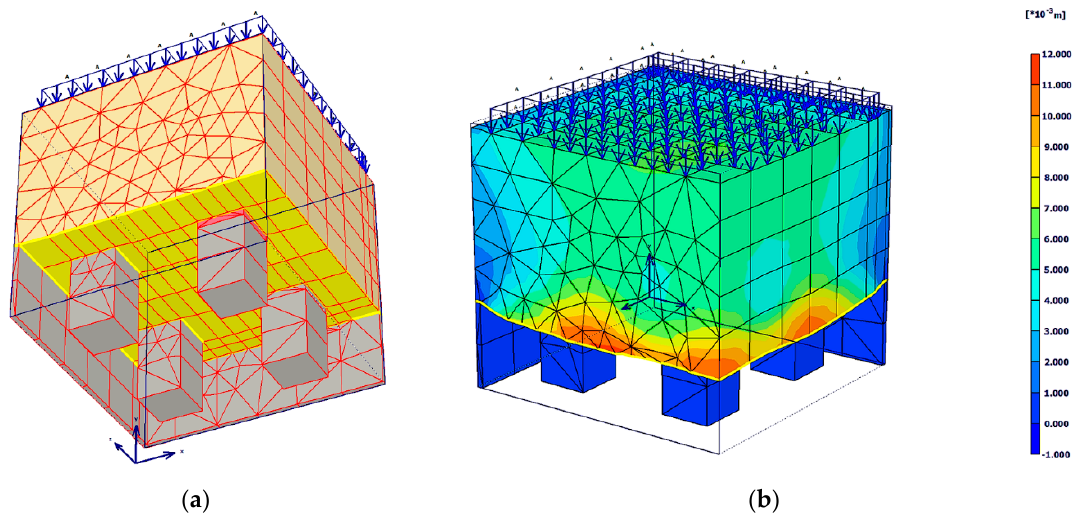
Figure 12. A quarter symmetrical 3D model view from bottom ( a ); total deformations of model after final stage of load 93 kPa at the top ( b ).